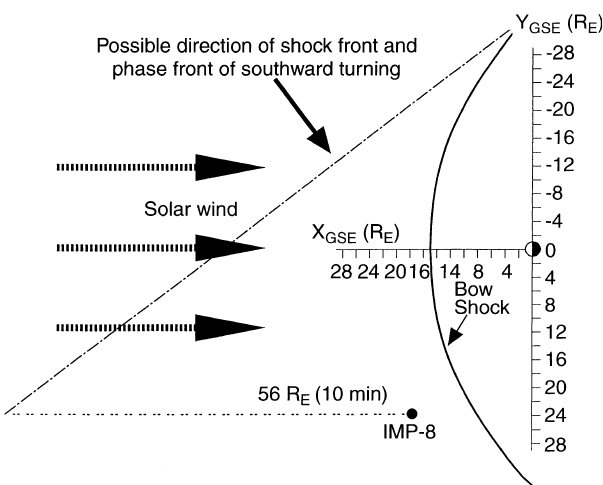
Fig. 4. Schematic presenting the inferred geometry of the shock front associated with the SSC at 2243 UT on March 20. The geometry of the bow shock has been deduced from the empirical models of Neˇ mecˇ ek and Sˇ afra´ nkova´ (1991). See text for details. The plane of the shock reached the bow shock 10 min prior to detection by the